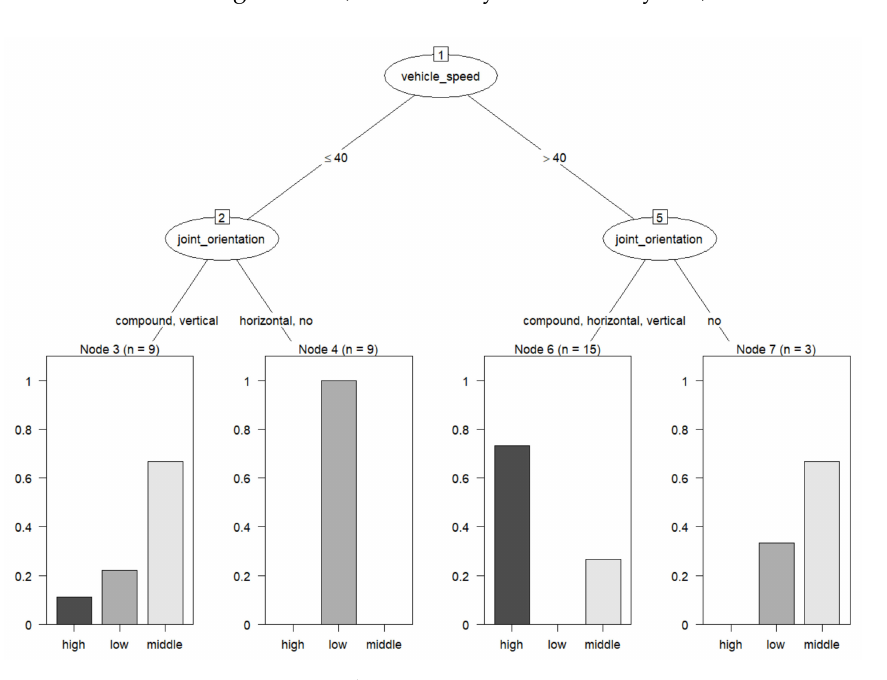
Figure 8. Decision tree using train